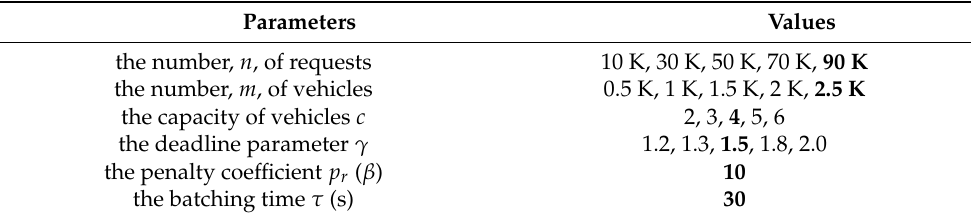
Table 4. Experimental